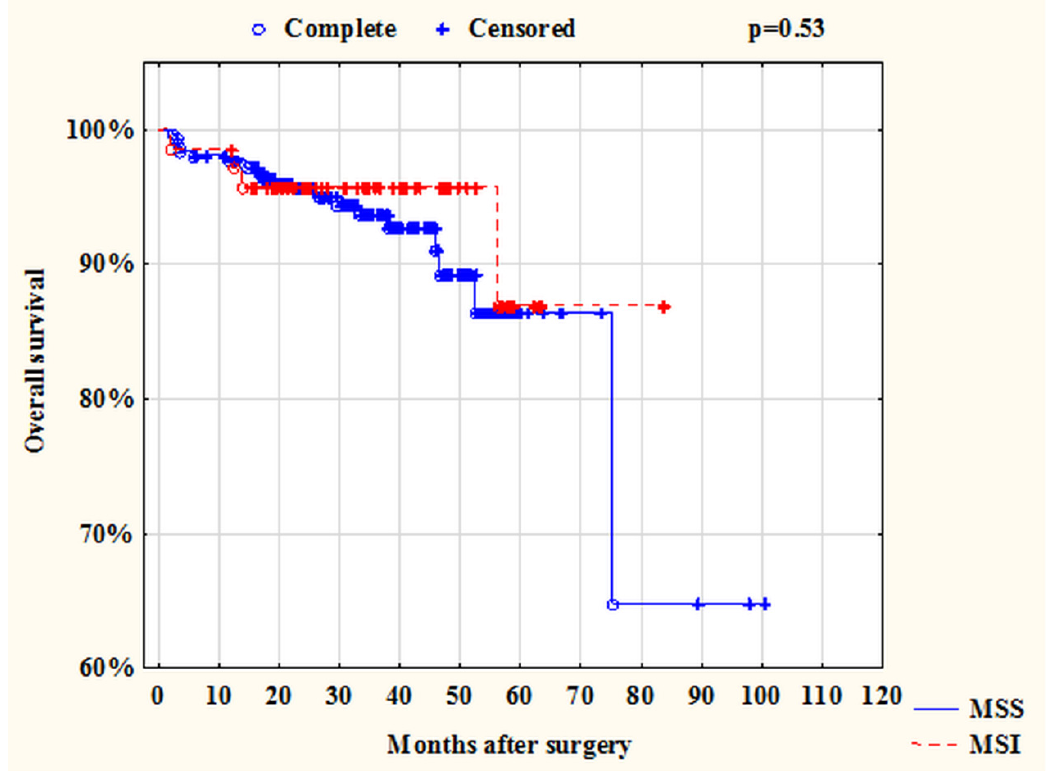
Figure 7. Overall survival of patients with CRC (stages I–III) depending on the status of microsatellite instability.